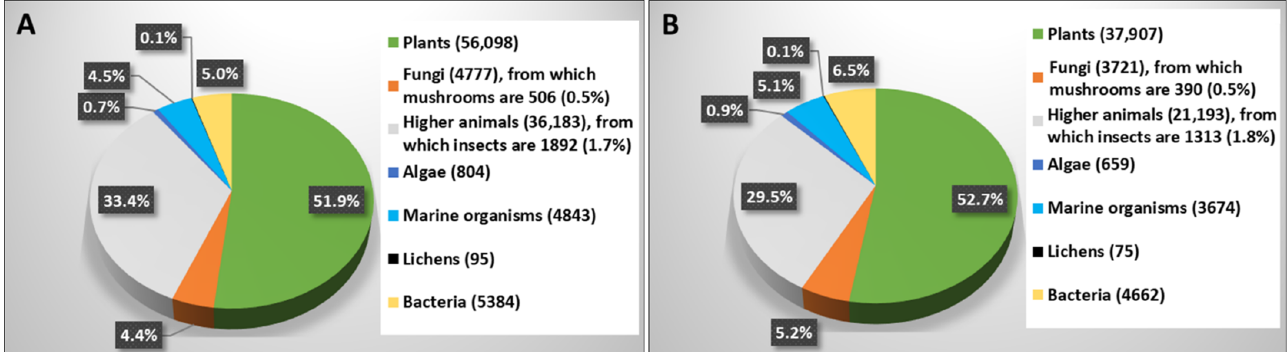
Figure 1. Distribution of references on alkaloids in the database SciFinder ( A ) without a time filter; ( B ) from 2002 to 30 May 2022. References were obtained using the keyword “alkaloid”, plus the corresponding keyword for each type of organism. The number of references for each item are shown in parentheses.